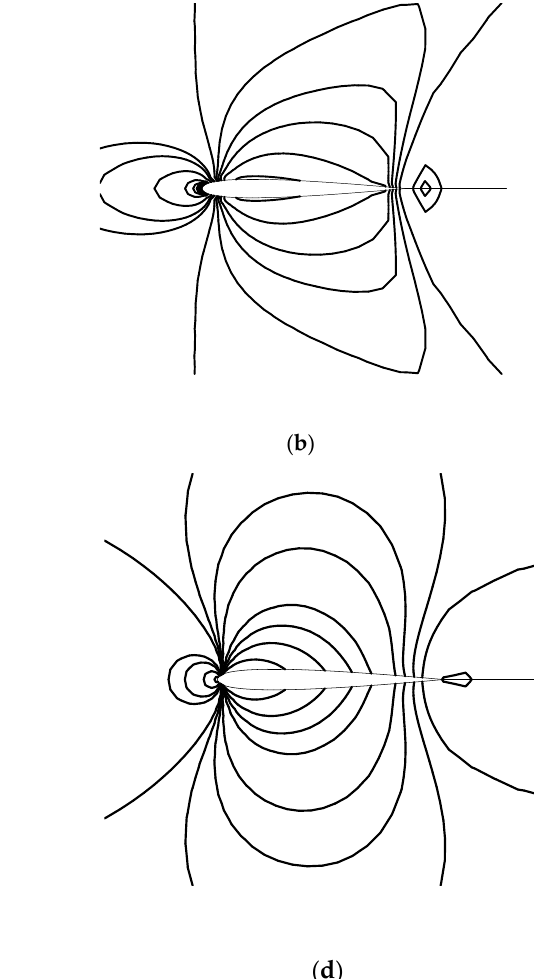
Figure 11. Schemes’ pressure contours of inviscid flows around NACA0012 airfoil with the first order reconstruction (Ma = 0.1, coarse grid); ( a ) AUSM+; ( b ) AUSMPW+; ( c ) SLAU; ( d ) AUSMAS.